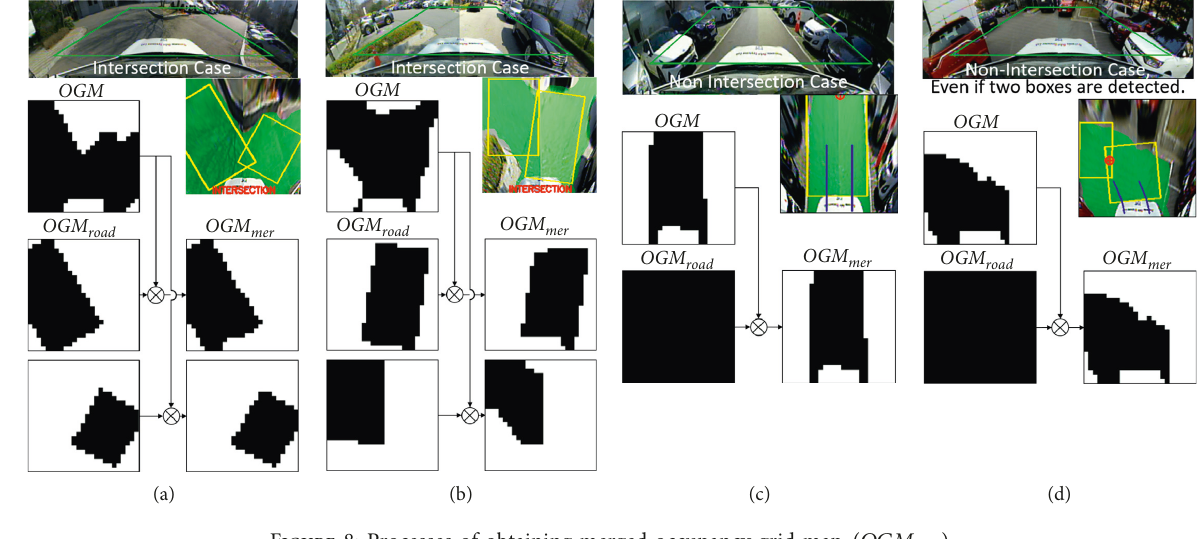
Figure 8: Processes of obtaining merged occupancy grid map ( OGM